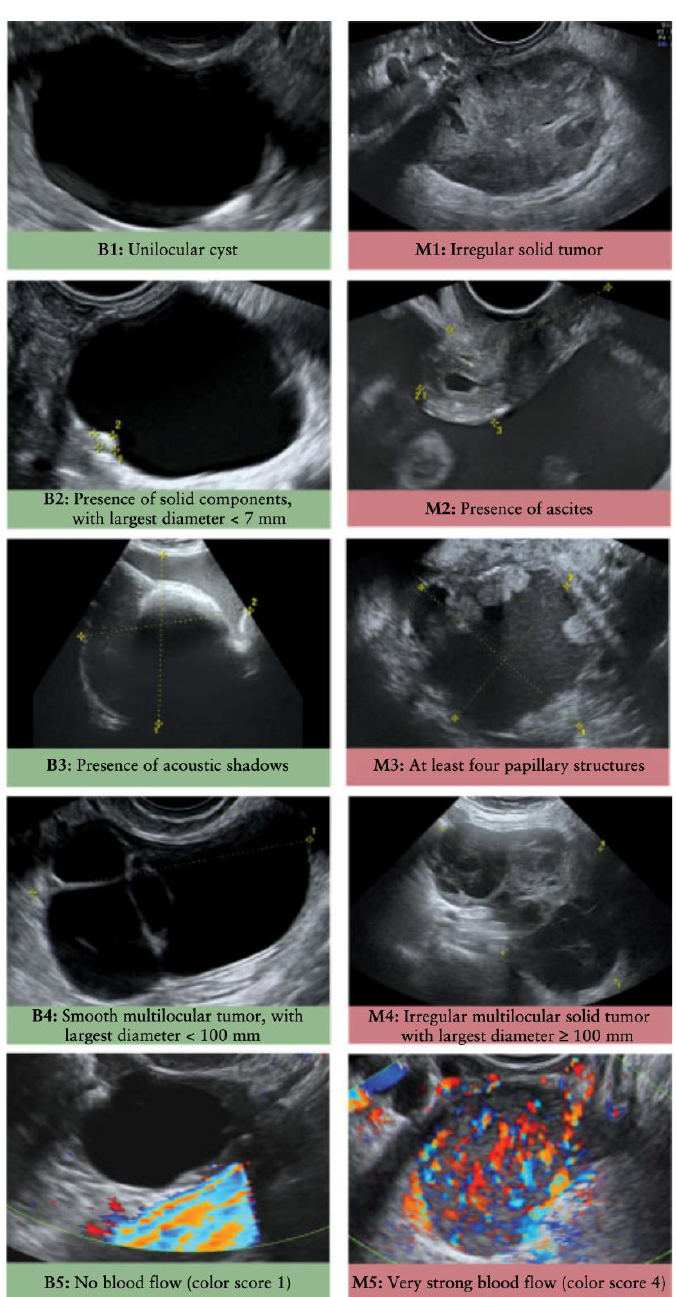
Figure 2. Representative sonographic images of benign ( B1 – B5 ) and malignant ( M1 – M5 ) ovarian masses. Features in each panel are reviewed based on the IOTA simple rules to evaluate malignancy of ovarian lesions. In general, the presence of irregular shaped bodies, papillary projections, and/or internal blood flow are predictive of malignancy. Images provided from Kaijser et al. [41]. Used with permission.